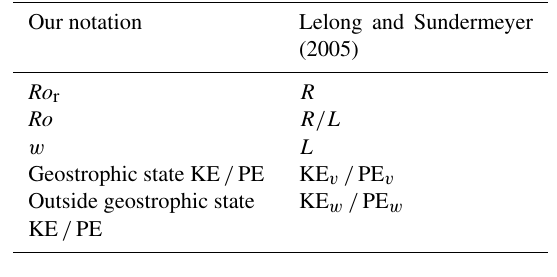
Table 2. A comparison of the notation in our work and that of Le- long and Sundermeyer (2005).